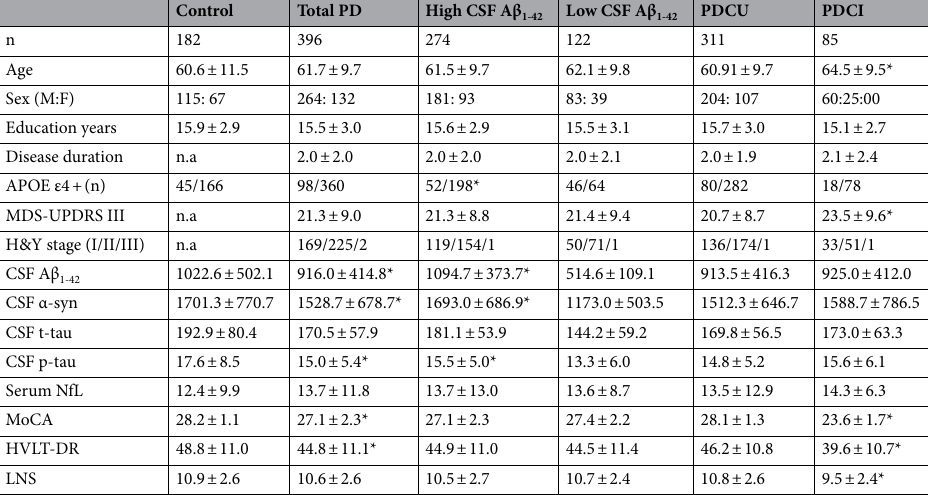
Table 1. Baseline demographics, biomarker levels and cognitive outcomes in PD and control subjects. Data are presented as mean ± SD. * P < 0.05 for total PD vs. controls, low CSF Aβ 1-42 vs. high CSF Aβ 1-42 , PDCU vs. PDCI. PDCU cognitively unimpaired PD; PDCI cognitively impaired PD patients; APOE apolipoprotein E; MDS-UPDRS III Movement Disorder Society sponsored Unified Parkinson’s Disease Rating Scale part III; H&Y stage Hoehn & Yahr stage; Aβ 1-42 amyloid-β 1-42 ; α-syn α-synuclein; t-tau total tau; p-tau = phosphorylated tau; NfL neurofilament light chain; MoCA total scores of Montreal Cognitive Assessment; HVLT-DR delayed recall score in Hopkins Verbal Learning Test; LNS total scores of Letter-Number Sequencing test; n.a. not